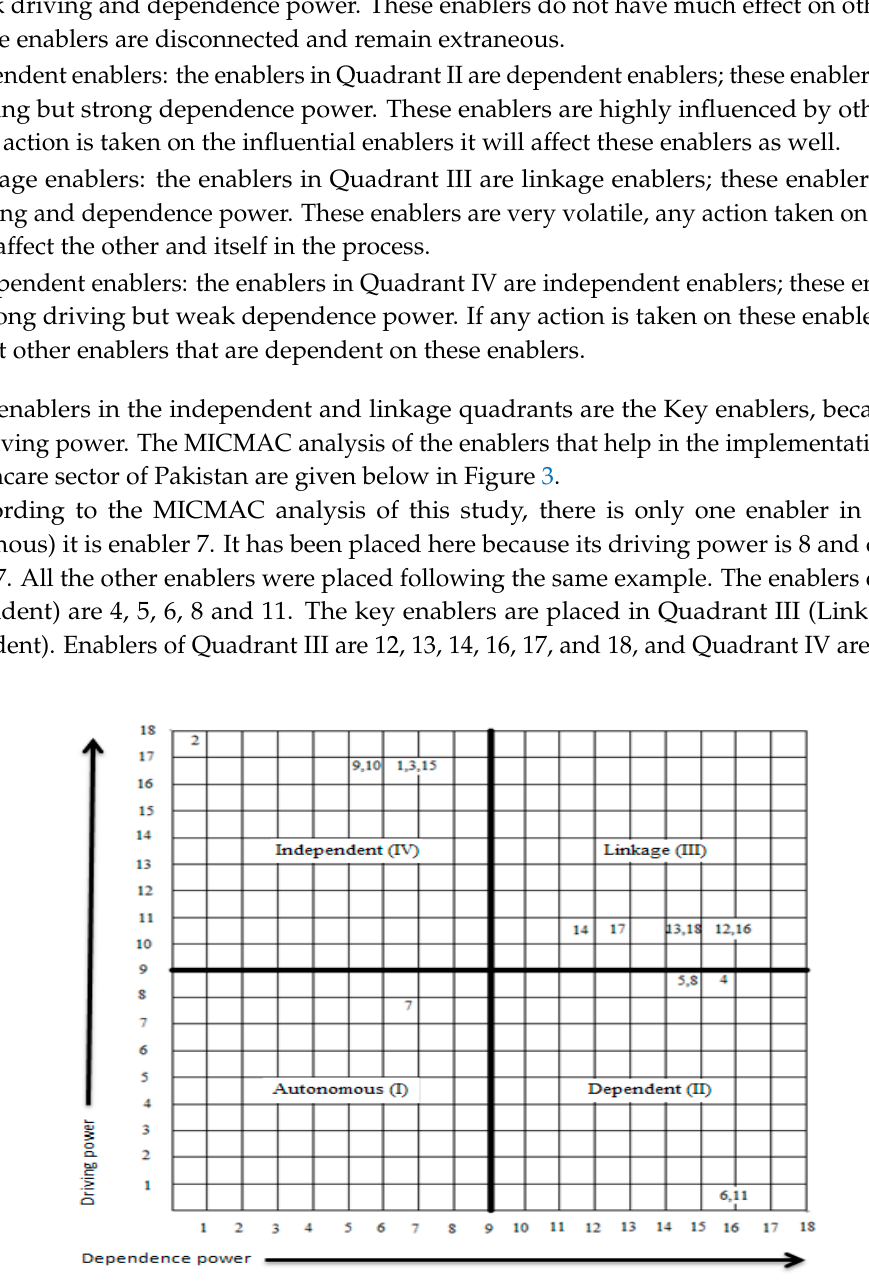
Figure 3. Driving v/s dependence power using MICMAC analysis.